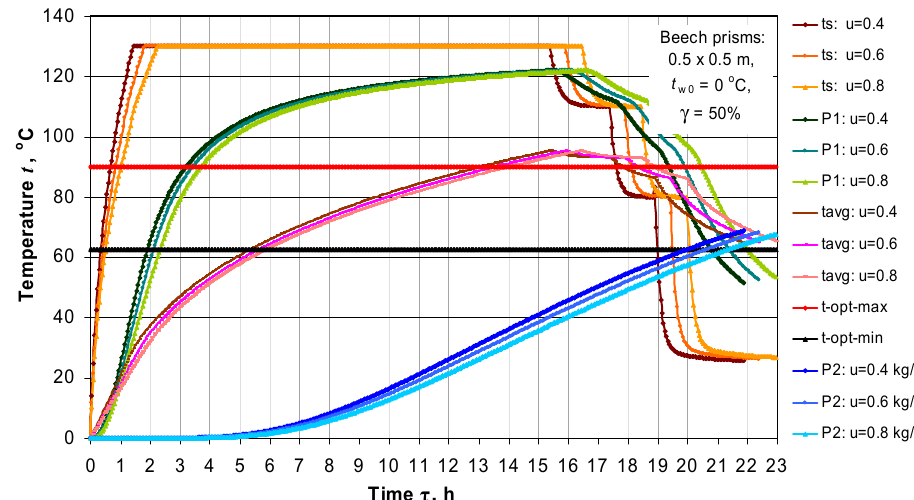
Figure 8. Changes in t s , t w-avg , and t in 2 characteristic points t 1 and t 2 of the prisms with d × b = 0.5 × 0.5 m during their steaming in an autoclave at γ = 50% and subsequent conditioning, depending on u and τ .